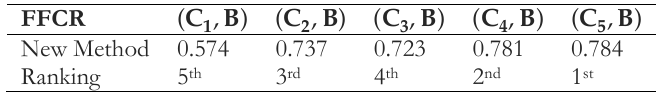
Table 7. Results from problem 2.